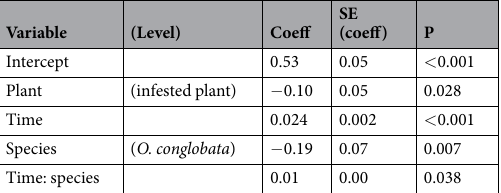
two olfactometer arms (Fig. 4, Table S8: P > 0.05 for all comparisons). Ovarian dynamics.